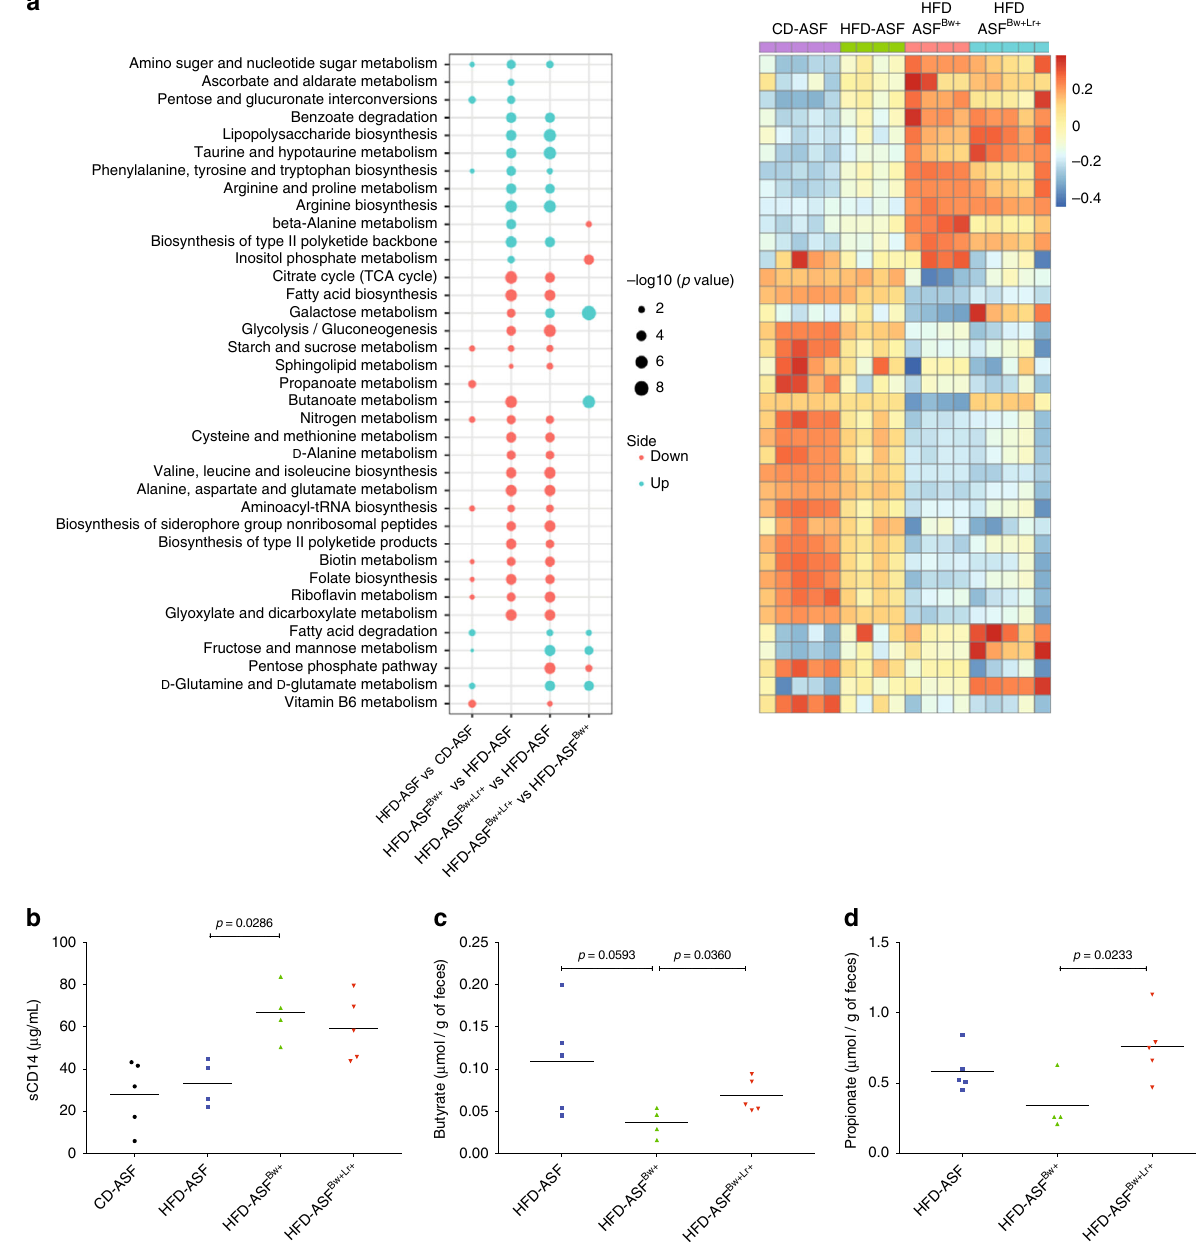
Fig. 5 The presence of B. wadsworthia and L. rhamnosus CNCM I-3690 induces changes in microbiota metatranscriptomics. a Left: Bubble plot of -log10(BH p -values) of a selection of signi fi cant pathway activities between indicated groups (Blue: up regulated in fi rst compared to second group. Red: down regulated in fi rst compared to second group); right: Heatmap of corresponding pathway activity. b Concentration of soluble CD14 in serum. c Butyrate and d propionate concentrations in the feces. Statistical comparison was performed by fi rst testing normality using Kolmogorov – Smirnov test and then ANOVA or Kruskal – Wallis test with Bonferroni or Dunn ’ s post hoc test. Error bars represents